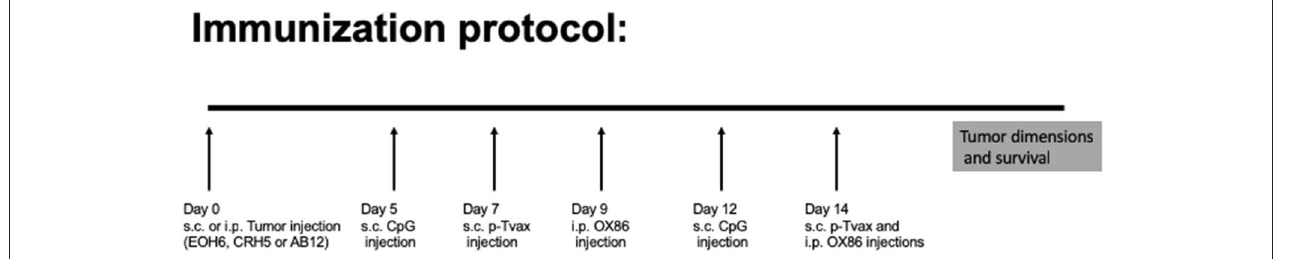
FIGURE 3 | Experimental approach to evaluate p-Tvax and OX40 agonists anti-cancer properties. Two s.c. vaccinations were administered with p-Tvax separated by 1 week. Two days before each p-Tvax immunization, CpG adjuvant injections were performed. To engage the OX40 receptor on T cells, we performed two injections of the OX86 mAb, with the first dose injected 5 d prior to the last p-Tvax vaccination, and the second on the same day as the last p-Tvax injection. Untreated controls and mice treated with the different immunotherapies were followed for tumor dimension and